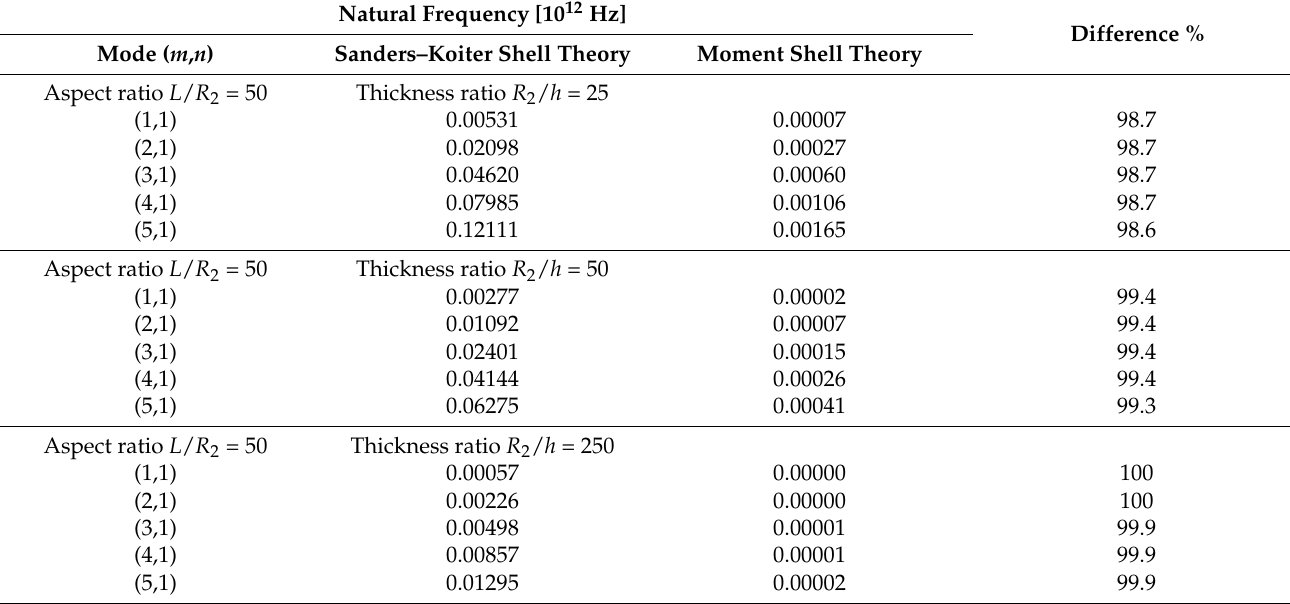
Table 13. Simply supported DWCNT with aspect ratio L / R 2 = 50 and thickness ratios R 2 / h = (25,50,250). Beam-like modes ( n = 1). Comparisons between Sanders–Koiter and moment shell